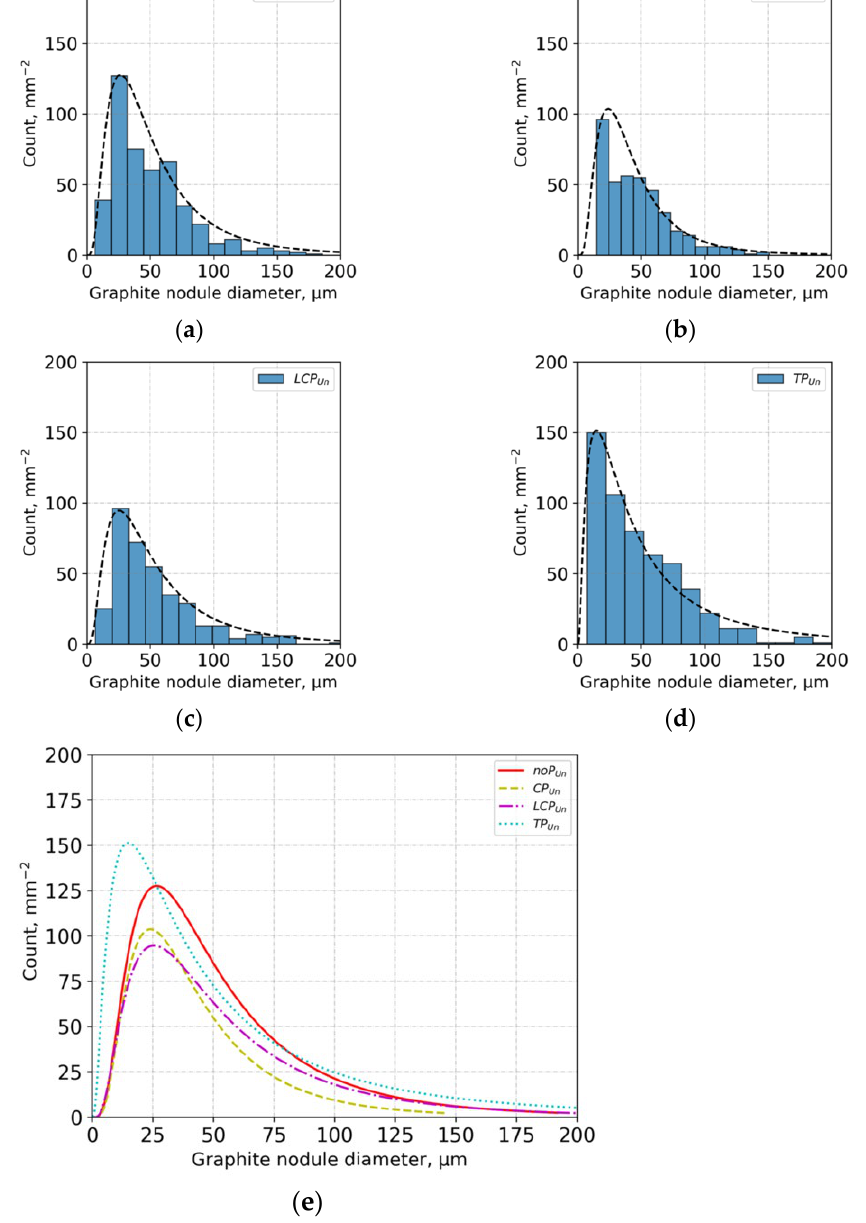
Figure 3. Optical microscopy images of samples unetched and etched of ( a ) noP Un , ( b ) CP Un , ( c ) LCP Un , and ( d ) TP Un samples.